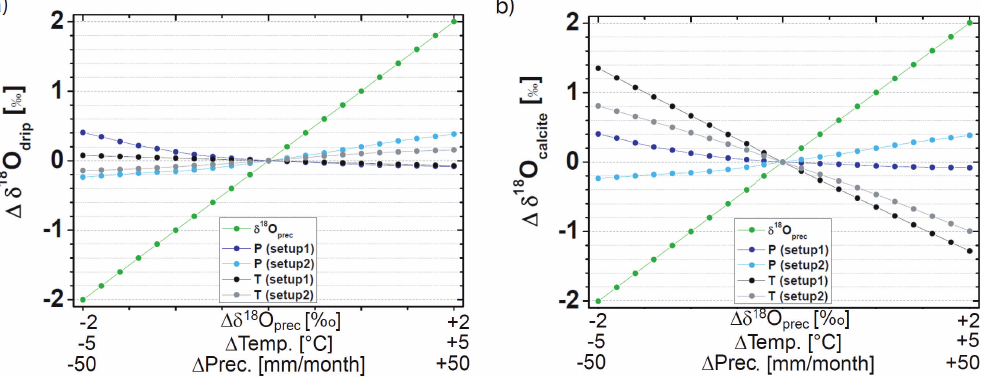
Fig. 2. Sensitivity of δ 18 O drip and δ 18 O calcite to temperature, precipitation and δ 18 O prec . Each parameter is varied in a certain range: temperature from − 5 ◦ C to +5 ◦ C, precipitation from − 50mmmonth − 1 to +50mmmonth − 1 and δ 18 O prec from − 2 to +2‰. The respective parameter shift is added to the whole time series and the ODSM recalculates the (a) mean δ 18 O drip , and (b) mean δ 18 O calcite with this modified data set. Note, that this figure shows the sensitivity as δ 18 O anomalies with respect to the standard experiment (centre dot). Drip water δ 18 O values refer to VSMOW and calcite values to